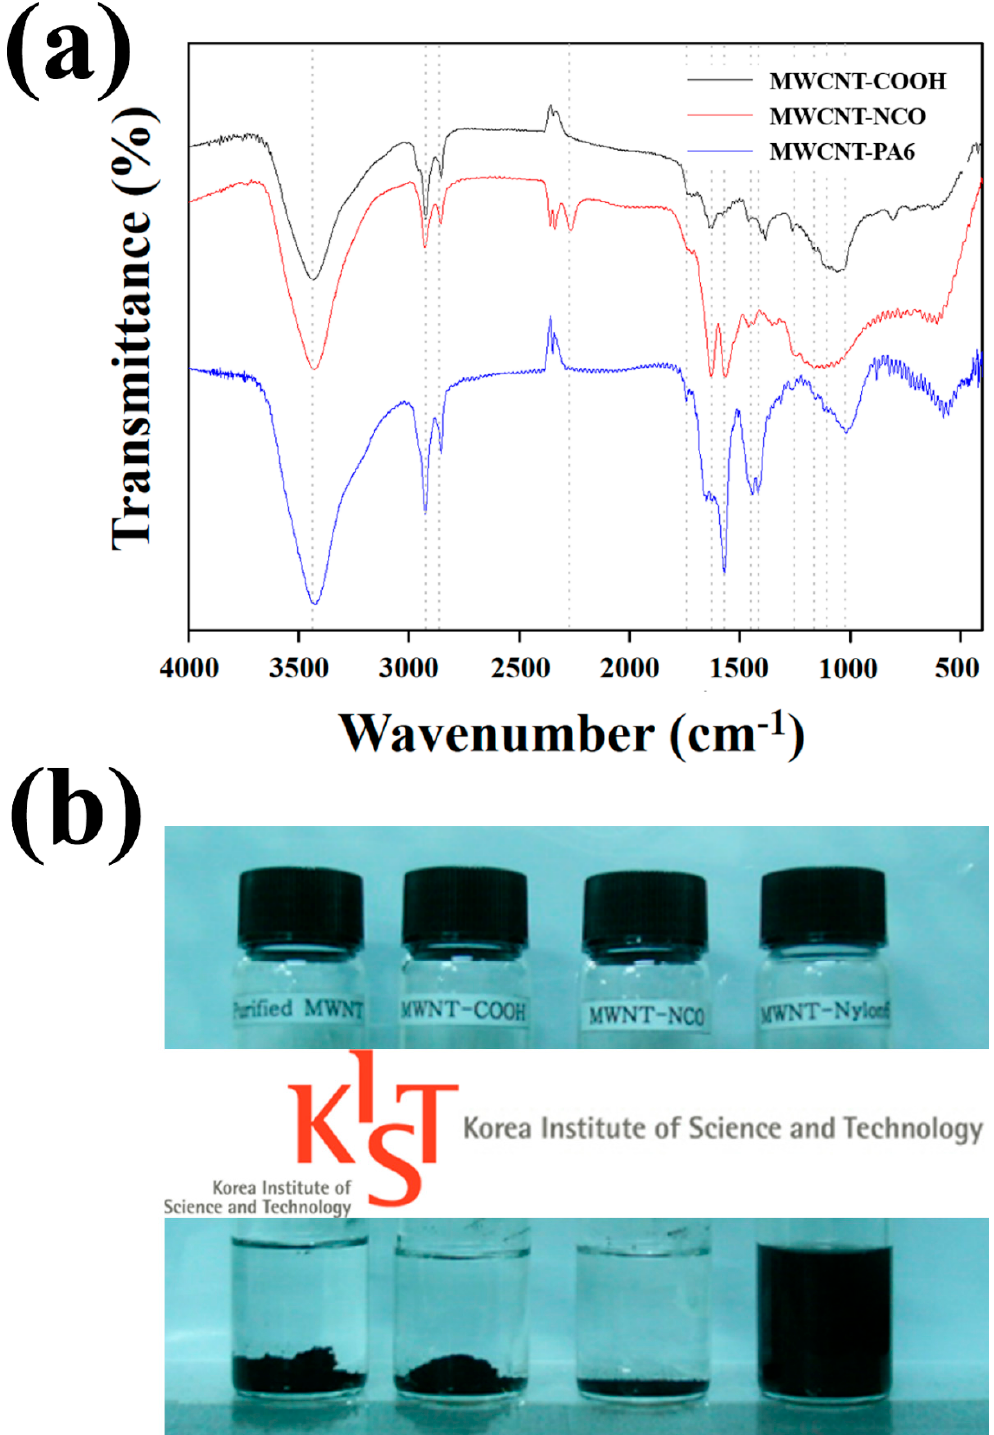
Figure 2. ( a ) Fourier transform infrared spectroscopy (FTIR) spectra of surface-treated multi-walled carbon nanotubes (MWCNTs) and ( b ) MWCNT dispersion in formic acid after 20 days after ultrasonication according to the surface treatment.